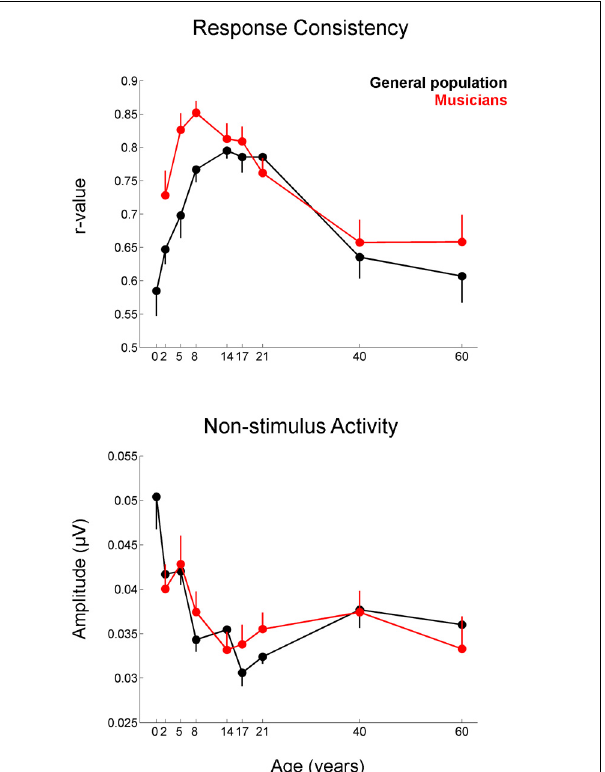
FIGURE 5 | Developmental trajectories for the measures of response consistency (top) and non-stimulus activity (bottom) of the cABR plotted for the musicians (red) and general population (black). Error bars represent one standard error of the mean (mean − 1 S.E. for the general population and mean + 1 S.E. for the musicians). The value reported on the x-axis represents the youngest age for each group. Musicians show a distinct trajectory for the response consistency measure ( p = 0 . 002) with the differences being most pronounced on the tail ends of the trajectory when the developmental trajectory is most in flux. The groups were matched on the measure of non-stimulus